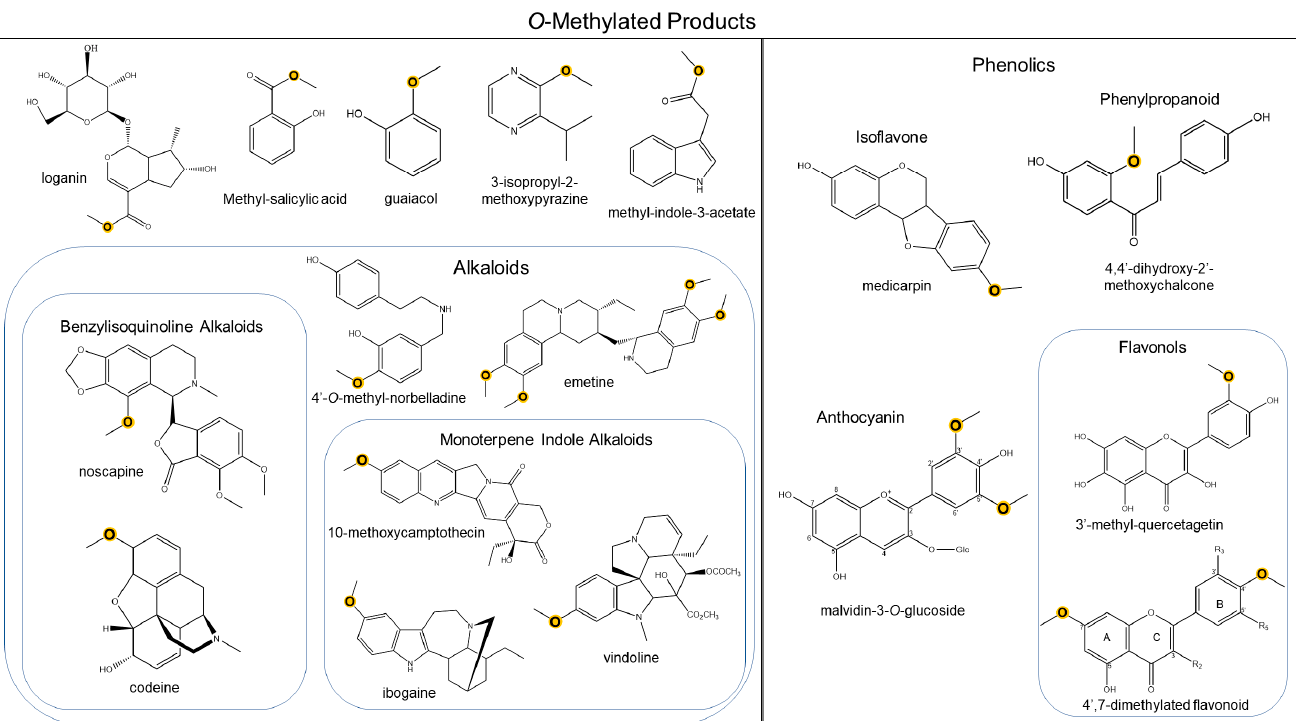
Figure 1. Representation of chemical diversity generated by O -directed methyltransferases. Methylated atoms are highlighted in yellow.